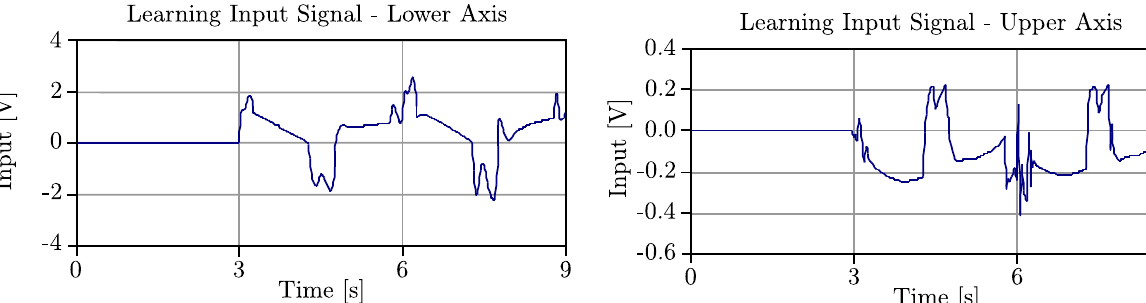
Figure 8: Learned feedforward signal - upper